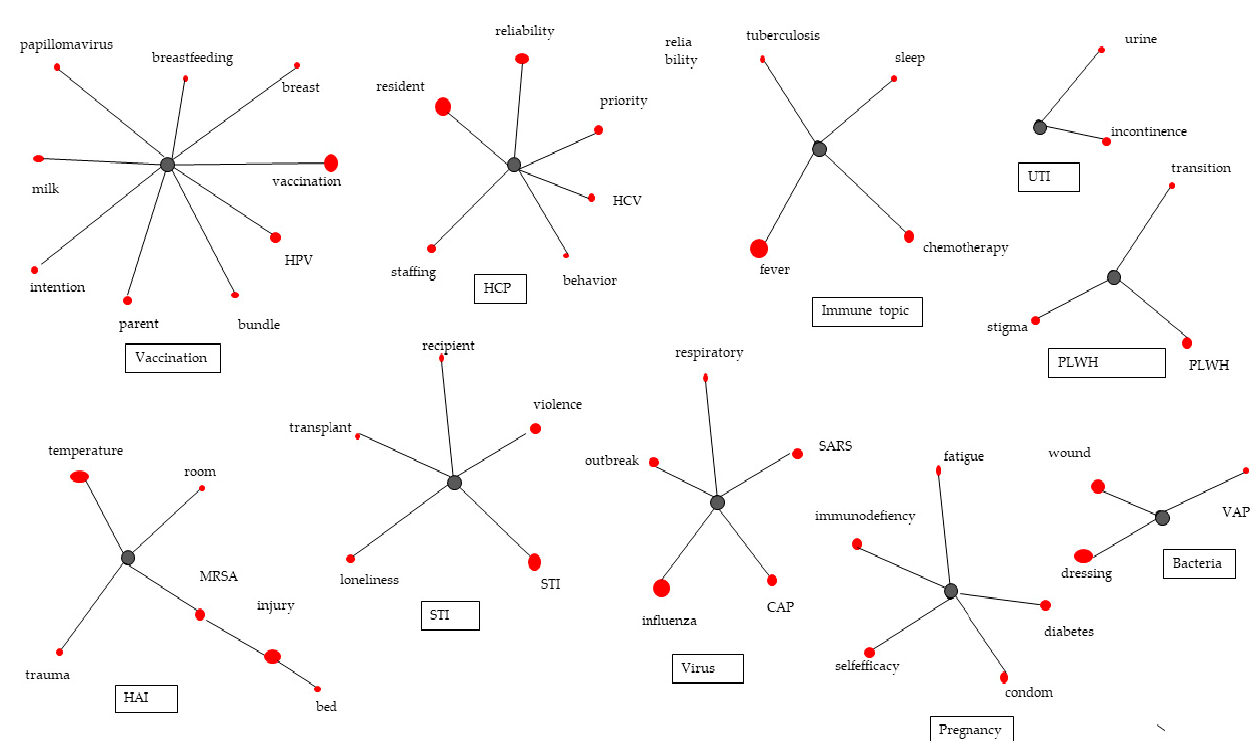
Figure 2. Sociogram of the keywords based on topic modeling. Note. HPV: human papillomavirus; HCP: healthcare professionals; UTI: urinary tract infection; PLWH: people living with HIV; MRSA: methicillin-resistant staphylococcus aureus; HAI: healthcare-associated infection; STI: sexually transmitted infection; SARS: severe acute respiratory syndrome; CAP: community-acquired pneumonia; VAP: ventilator-associated pneumonia .